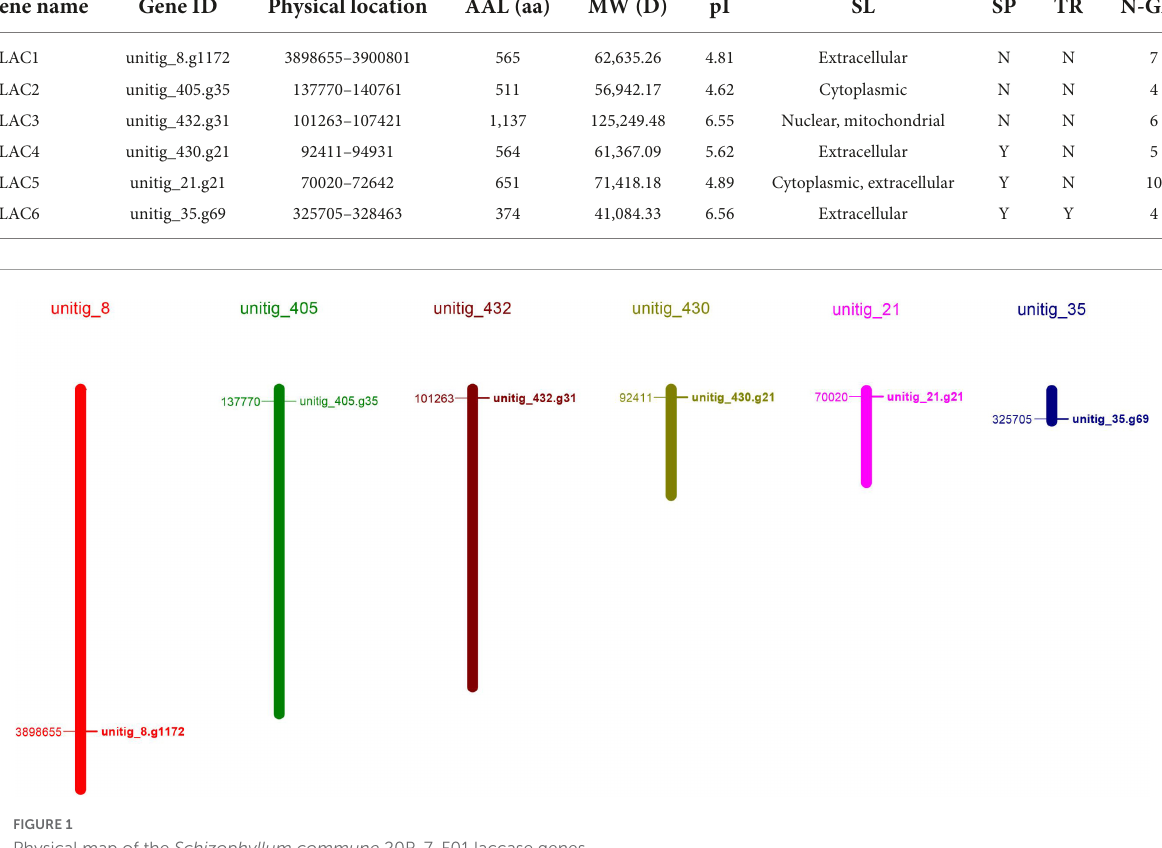
FIGURE1 Physical map of the Schizophyllum commune 20R-7-F01 laccase genes.